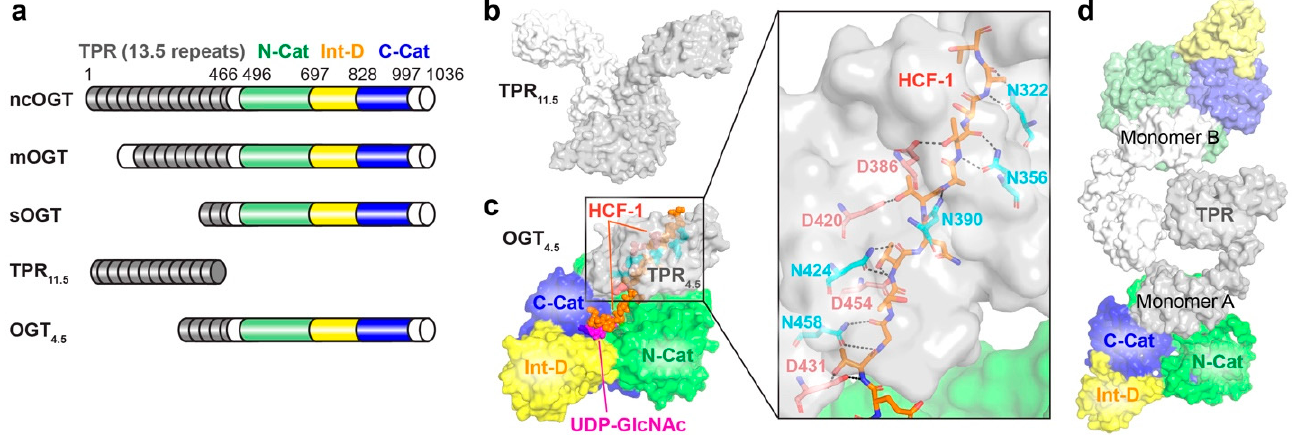
Figure 2. OGT structures provide insights into substrate recognition and protein interactions. ( a ) Schematic diagram of three OGT isoforms (ncOGT, mOGT, and sOGT) and the two truncated OGT constructs for crystallization (TPR 11.5 and OGT 4.5 ). The tetratricopeptide repeat domain (TPR), N-terminal catalytic domain (N-Cat), intervening domain (Int-D), and C-terminal catalytic domain (C-Cat) are colored in gray, green, yellow, and blue, respectively. ( b ) The crystal structure of TPR 11.5 in a dimer (PDB: 1W3B). ( c ) The crystal structure of OGT 4.5 in complex with UDP-GlcNAc and HCF-1 peptide (PDB: 4N3C). UDP-GlcNAc and HCF-1 peptide are highlighted in magenta and orange, while the asparagine and aspartate ladders are shown in cyan and salmon, respectively. Domains are colored as in ( a ). Insert: zoom-in at TPR 4.5 region showing detailed interactions between the peptide backbone/side-chains and asparagine/aspartate residues. ( d ) The cryo-EM structure of OGT in a dimer (PDB: 7NTF). Monomer A (in dark color) is missing two TPRs and monomer B (in light color) is missing five TPRs at the N-terminus.